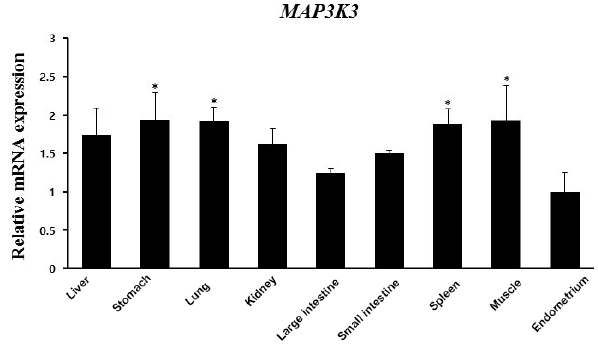
Figure 4. MAP3K3 mRNA expression in various tissues (liver, stomach, lung, kidney, large intestine, small intestine, spleen, mus- cle, and endometrium) as determined by RT-PCR. Peptidylprolyl isomerase A (PPIA) was used as an internal control. The fold change in mRNA expression level was calculated by comparing the lowest expression level in the endometrium with that in the other tissues. Data represent mean ± SD. ∗ represents p< 0 .